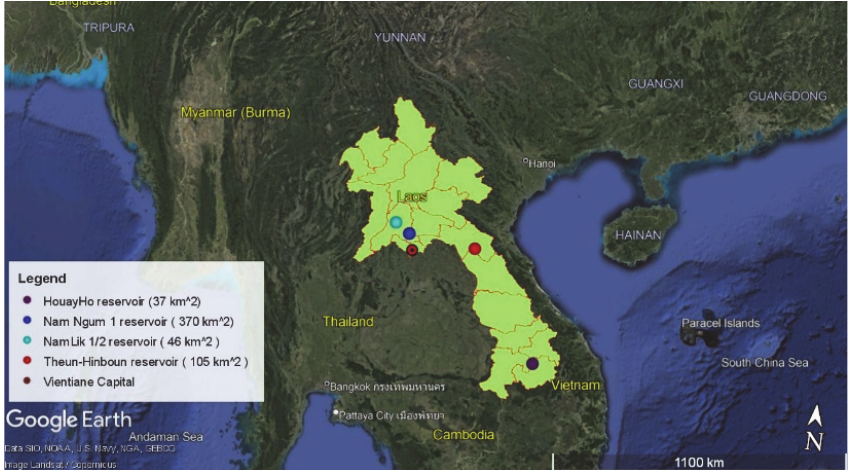
Figure 1. Map of Laos highlighting the provincial boundaries and the location of the four existing hydropower reservoirs considered for FPV potential estimation.